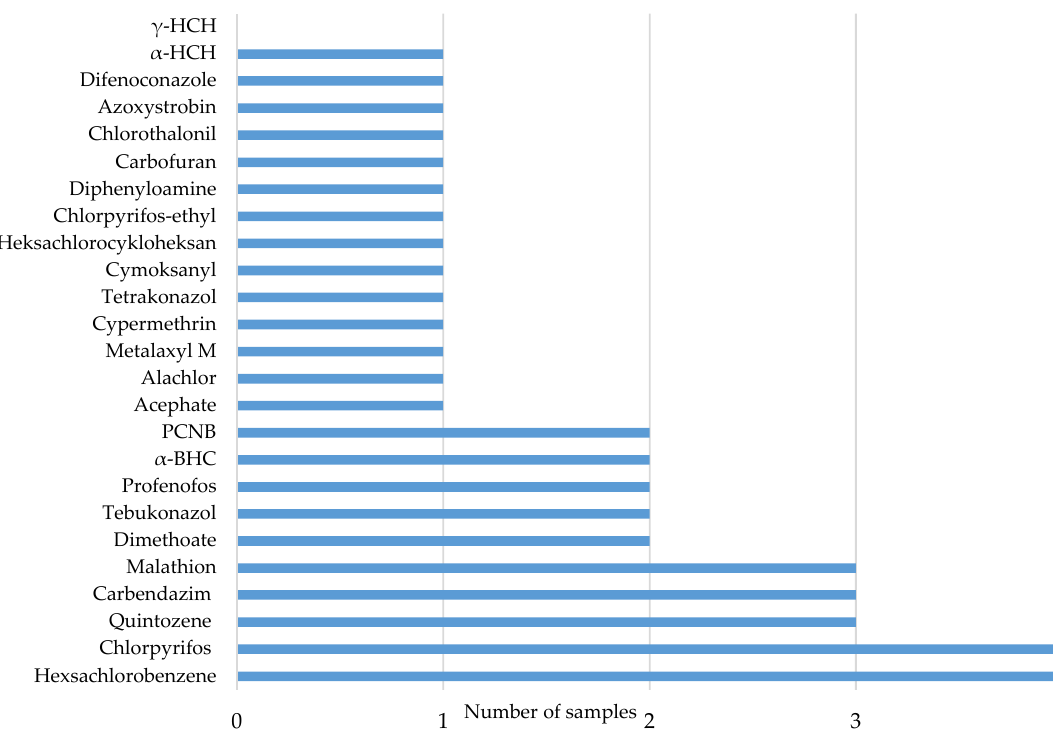
Figure 3. The most-frequently-detected compounds in fruit and vegetable samples (see literature reports in Table 3).